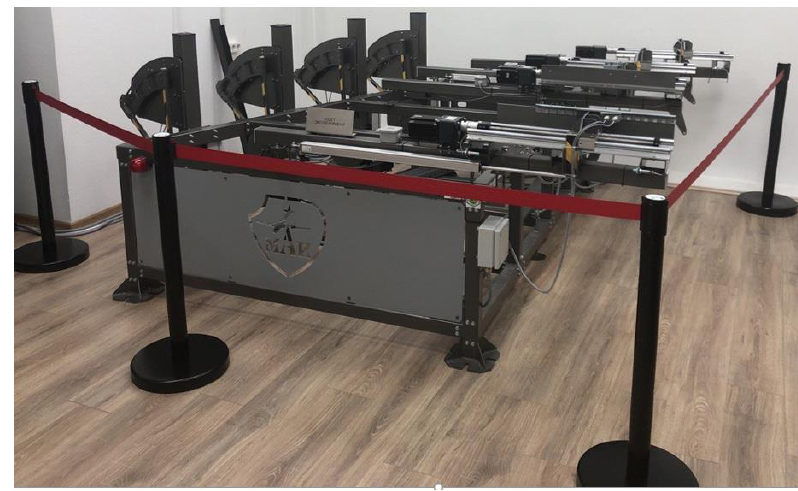
Figure 8. General view of the SCS stand.